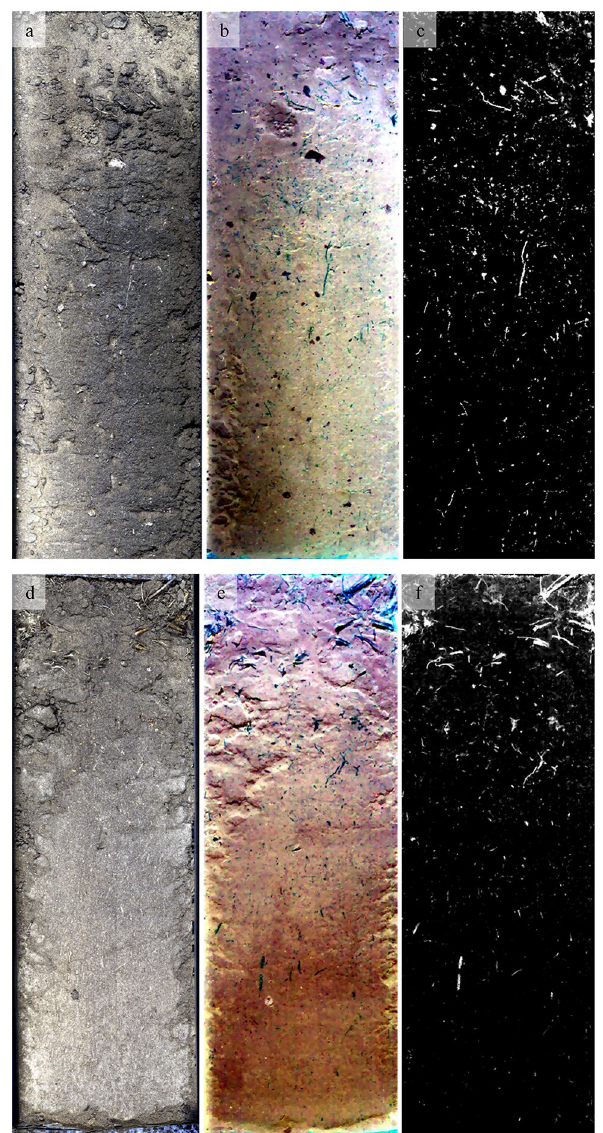
Figure 4. True color images of the VNIR-1600 ( a and d ; red: 660 nm, green: 560 nm, blue: 480 nm), false color images of the SWIR-385 ( b and e ; red: 2276 nm, green: 2204 nm, blue: 2012 nm; corresponding to the lines 5, 3, and 1 in Fig. 2), and fractional cover of the organic fraction for the soil profiles grazed 2 and ungrazed 2 ( c and f ; bright pixels show a high contribution of organic matter). Both profiles are 30 cm long and 9 cm